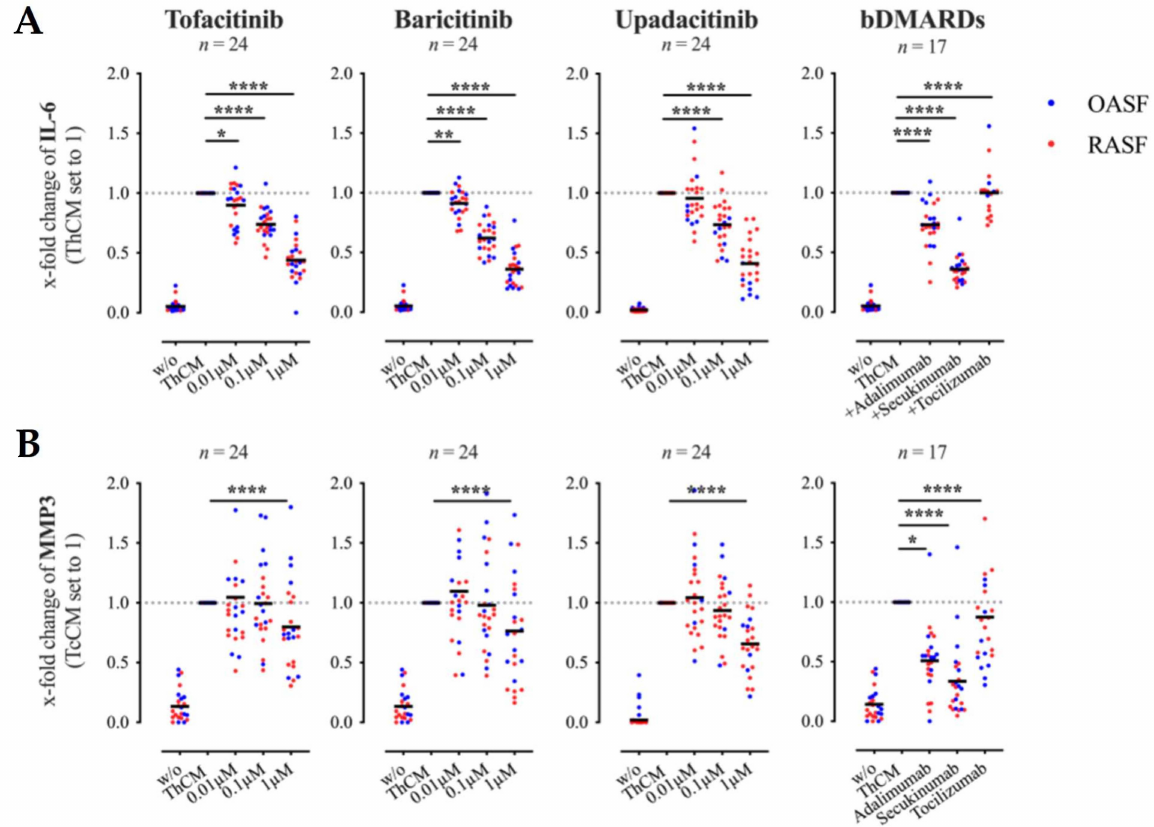
Figure 3. Effects of tofacitinib, baricitinib, upadacitinib and bDMARDs on IL-6 ( A ) and MMP3 ( B ) expression by SF stimulated with conditioned culture medium of Th cells (ThCM). Th cells were stimulated with anti-CD3/anti-CD28 antibodies and supernatants (ThCM) were collected on day 4. RASF (red) or OASF (blue) were cultured with or without ThCM and treated, respectively. Supernatants were collected on day 5 and analyzed by ELISA. Results are presented as x-fold change with SF stimulated with ThCM set to 1 (mean concentrations ± SEM in ng/mL: IL-6: 244.64 ± 20.62; MMP3: 42.64 ± 8.97). Data shown as grand mean, significance tested using Wilcoxon signed-rank test, p **** ≤ 0.0001, p ** ≤ 0.01, p * ≤